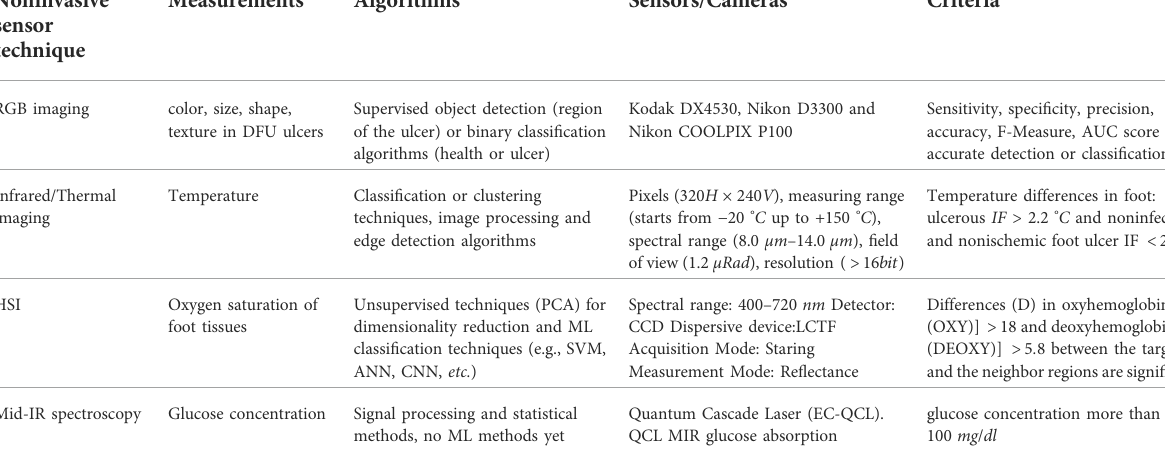
TABLE 2 Synergies between machine learning tools and non-invasive methods for DFU